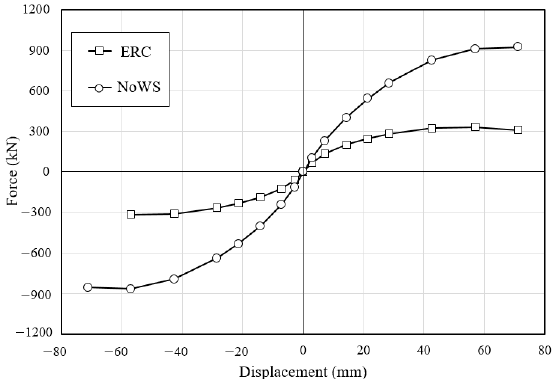
Figure 11. Envelope curves. Table 4. Summary of experimental results.